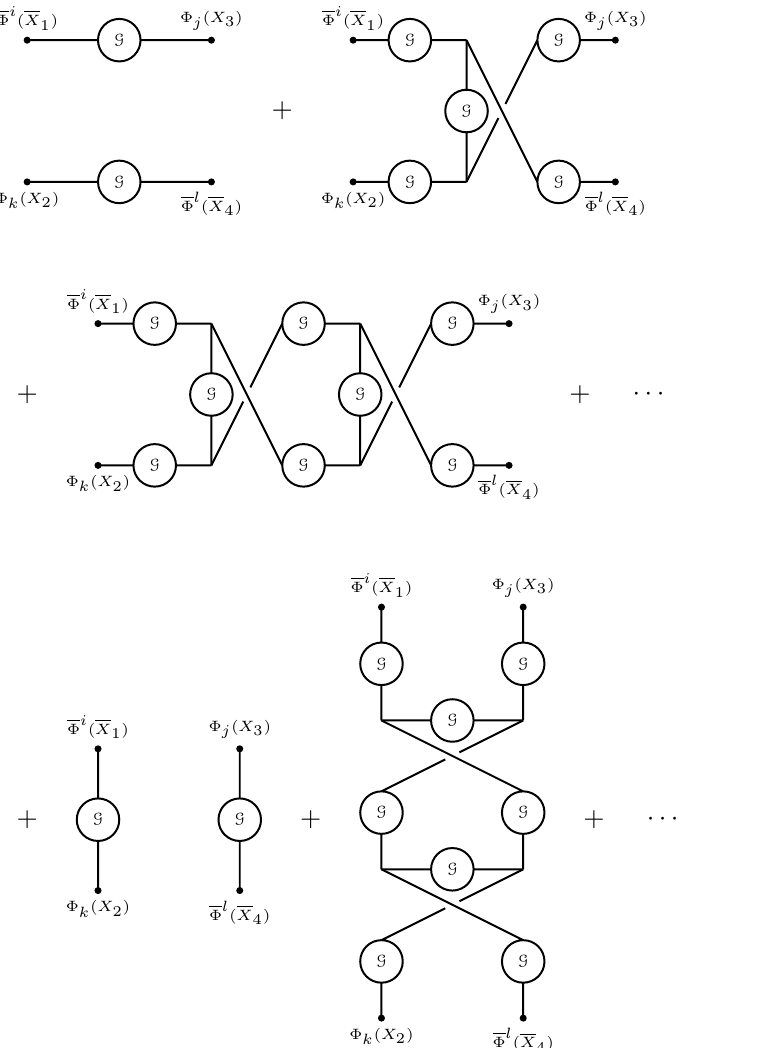
Figure 2 . The diagrammatic expansion of the four-point function of superfield Φ and its conju- gate (3.1) in the disorder averaged large N